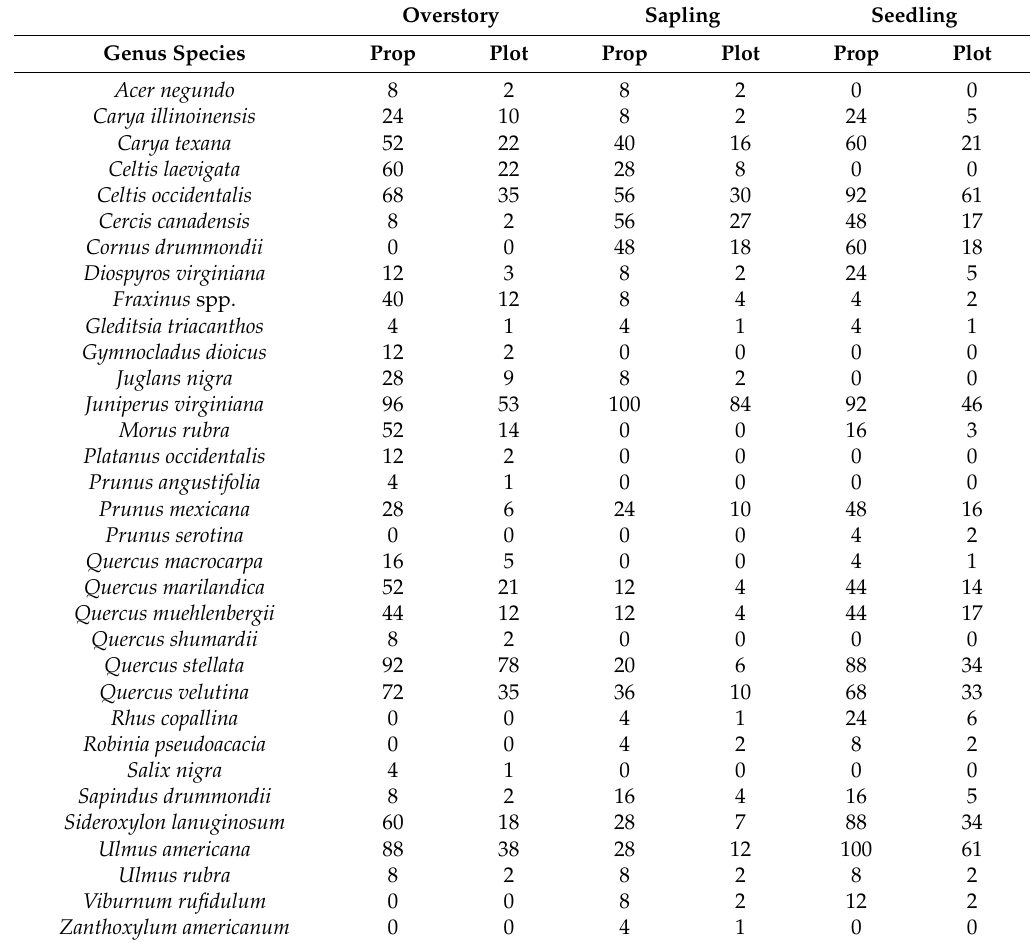
Table 3. Number of times that species were identified on properties (Prop; 25) or plots (130, 5 plots per property with 1 property having 10) for overstory trees (dbh >10 cm), saplings (dbh 0.1 to 10 cm), and seedlings (shorter than 1.37 m), expressed as a percent. Overstory trees were measured in plots 0.04 ha in size. For hardwoods, saplings were measured in plots 0.004 ha in size and seedlings were measured in plots 0.001 ha in size. Juniperus virginiana saplings and seedlings were measured in the 0.04 ha plots. For seedlings, all Celtis spp. are lumped as Celtis occidentalis